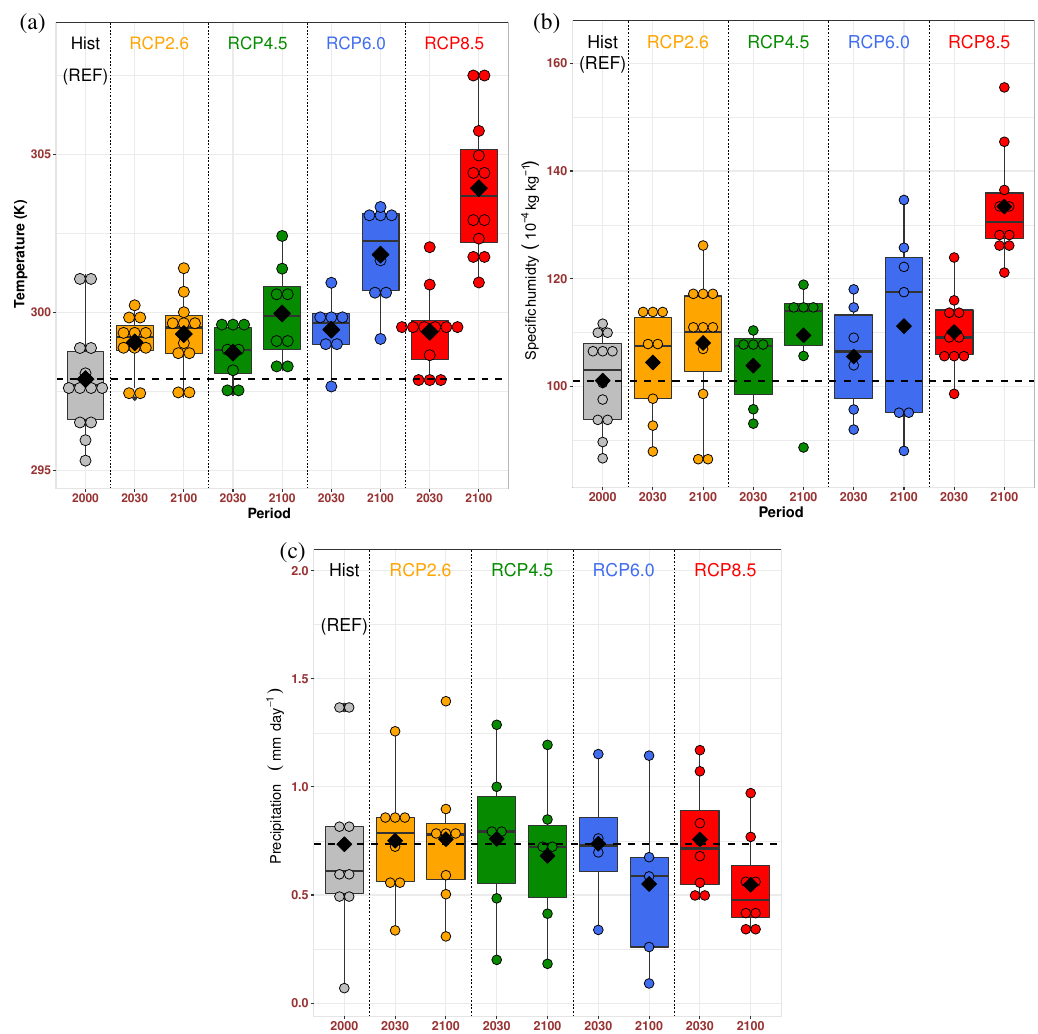
Figure 6. Box-and-whisker plots of the summer (JJA) average of (a) temperature in Kelvin (K), (b) specific humidity and (c) precipitation since 2000, calculated over the Mediterranean Basin domain (see Fig. 1) for the JJA period and for RCP2.6 (yellow), RCP4.5 (green), RCP6.0 (blue) and RCP8.5 (red). The historical period, considered as the reference, is in grey. The median is indicated by a horizontal black solid line and the multimodel mean by a filled black diamond. The range (25–75%) is represented by the length of each colored box and the minimum/maximum (excluding outliers) by the whisker. Each filled circle represents a single model. RCPs are − 14 % ( − 38 %) for RCP2.6, − 9 % ( − 24 %) for RCP4.5, − 10 % ( − 29 %) for RCP6.0 and − 1.3 % ( − 0.8